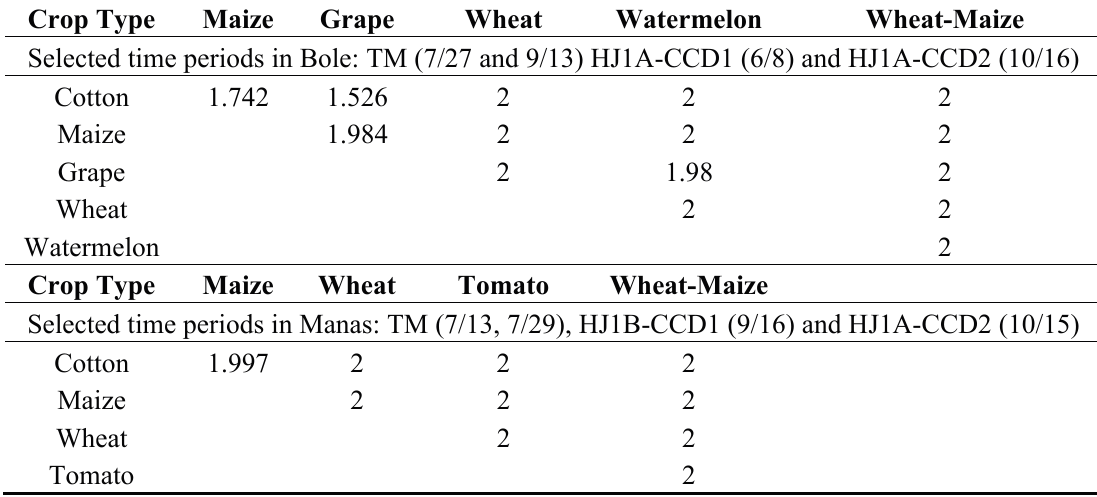
Table 6. JM distance for all pairwise crop comparisons for the optimal temporal window. Crop